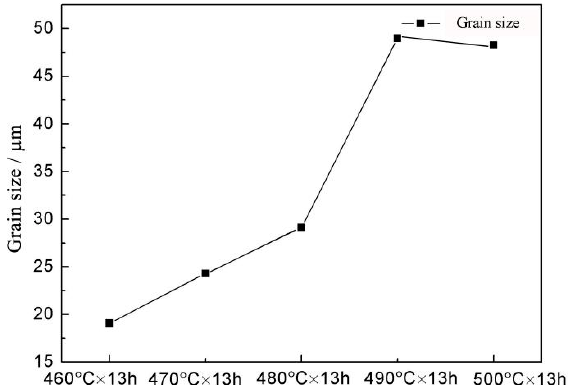
Figure 3. Grain size diagram of magnesium alloy at different solution temperature.